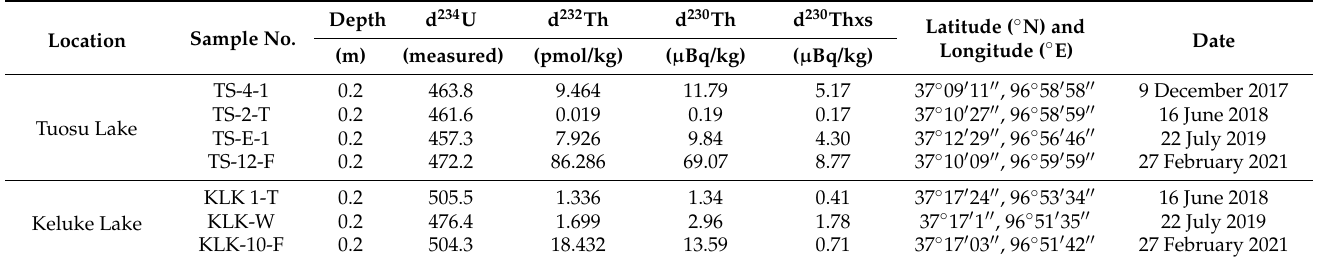
Table 3. Seasonal changes in dissolved Th isotope in Tuosu Lake and Keluke